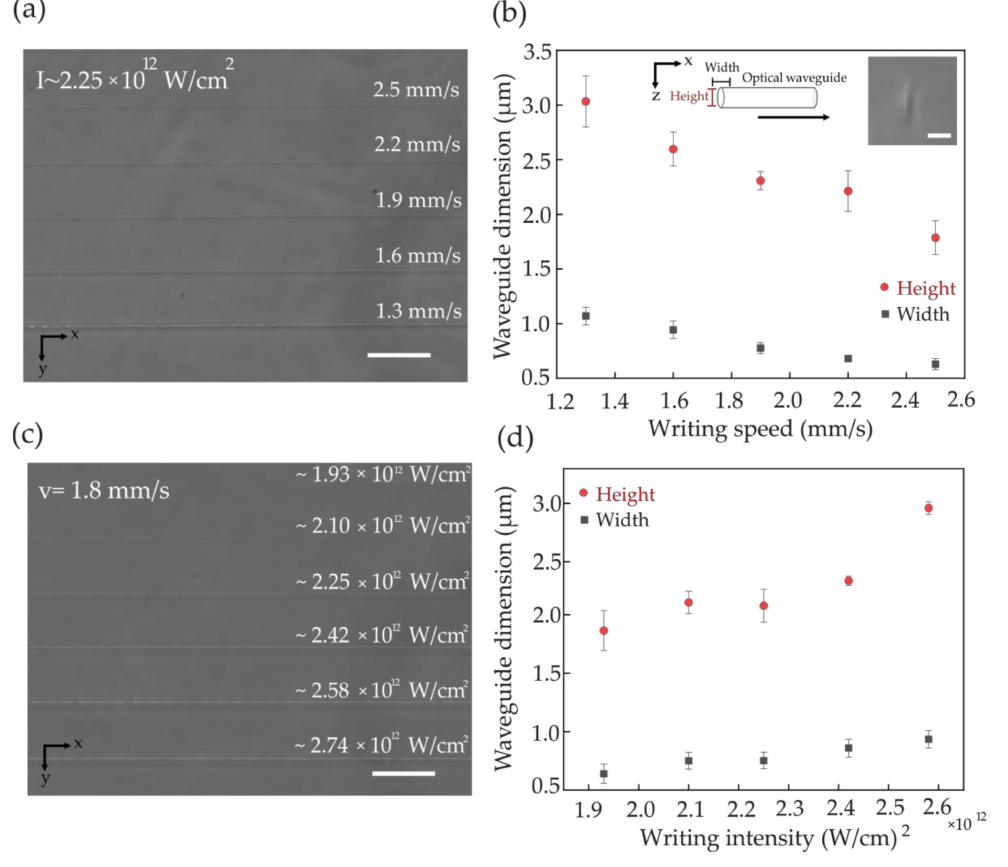
Figure 3. ( a ) Phase-contrast microscopy top view image of the recorded poly-DVB optical waveguides written at constant peak intensity I ~ 2.25 × 10 12 W / cm 2 and varying fabrication speed, ranging from 1.3 to 2.5 mm / s; ( b ) Waveguide width and height evolution as a function of increasing writing speed where the error bar derives from the measurement of three waveguides; the inset shows the cross-sectional view of a single-track waveguide where the scale bar measures 5 µ m; ( c ) and ( b ) display the same as above as a function of increasing fabrication peak intensity from 1.93 to 2.74 × 10 12 W / cm 2 and constant speed v = 1.8 mm / s. Error bars indicate the standard deviation derived from the measurement of five di ff erent waveguides geometry. Scale bars dimension in ( a ) and ( c ) is 50 µ